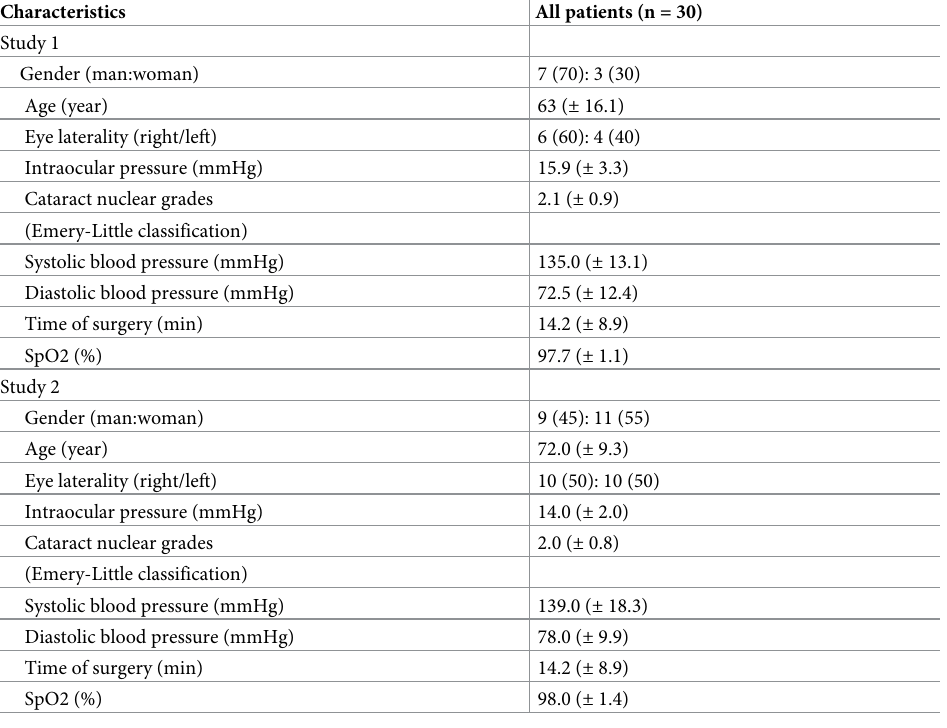
Values are presented as average ( ± standard deviation) or number